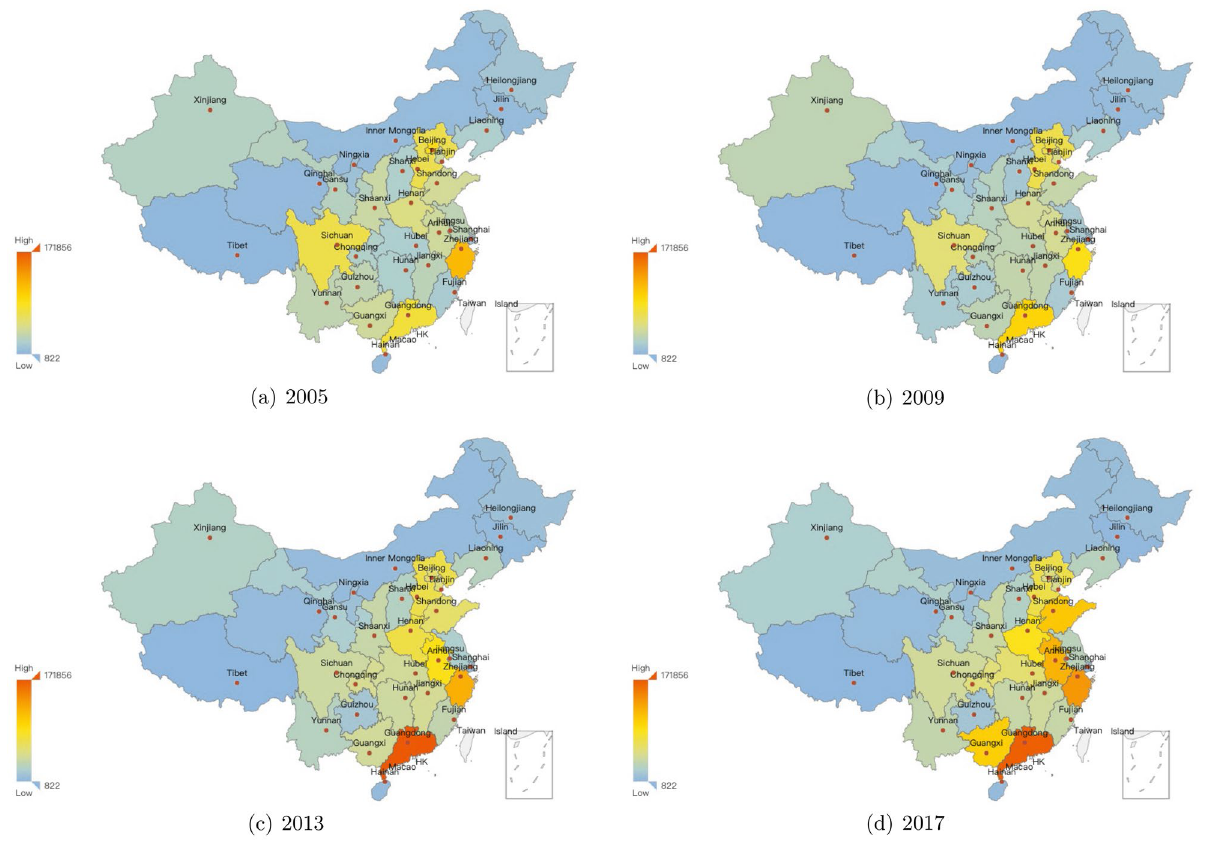
Figure 4. Provincial numbers of infectious diarrhea cases in mainland of China, in four different years during 2005–2017. The map is generated by an open source package called pyechart in Python 63